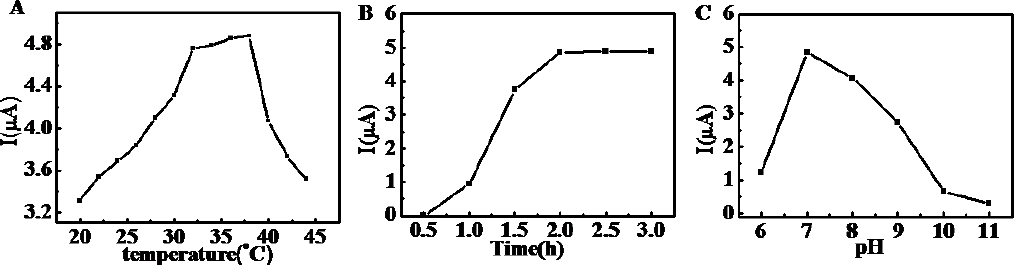
Figure 3. Effects of the temperature ( A ), incubation time ( B ), and pH ( C ) in the presence of 5 μL Fc -